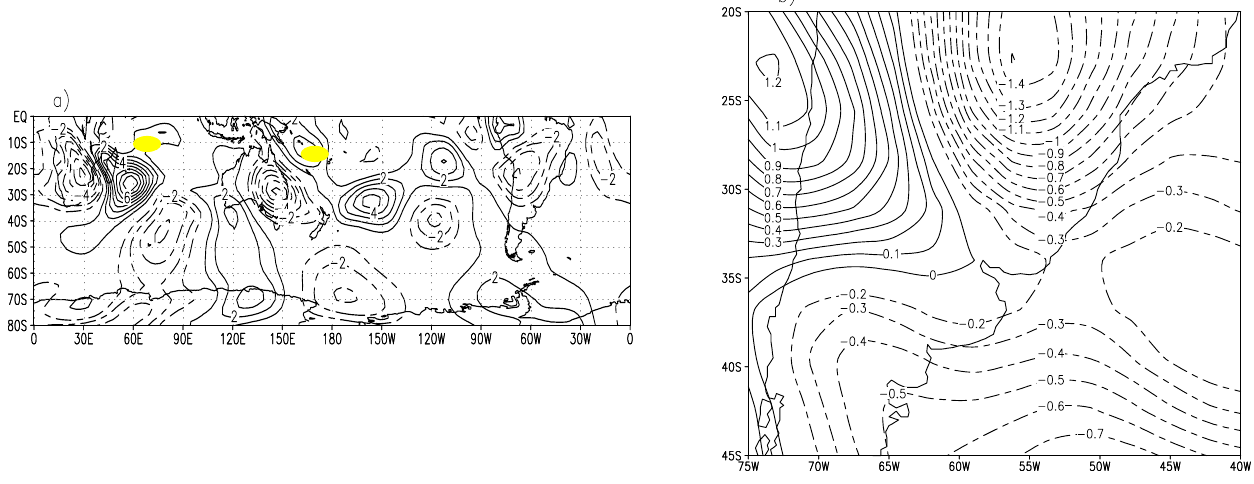
Fig. 7. (a) Meridional wind component anomalies (ms − 1 ) at 250hPa and (b) surface temperature anomalies ( ◦ C) on day 10 of integration, corresponding to + σ basic state experiment but using two heating sources at 170 ◦ E–15 ◦ S and 70 ◦ E–10 ◦